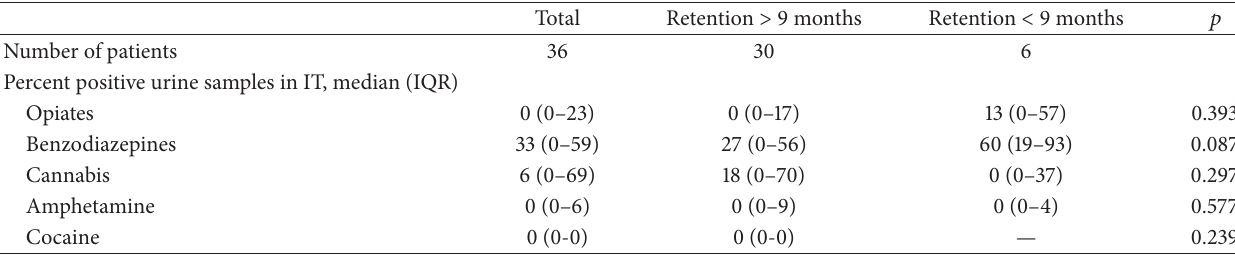
Table 2: Interim urine samples in relation to 9-month retention in OMT.